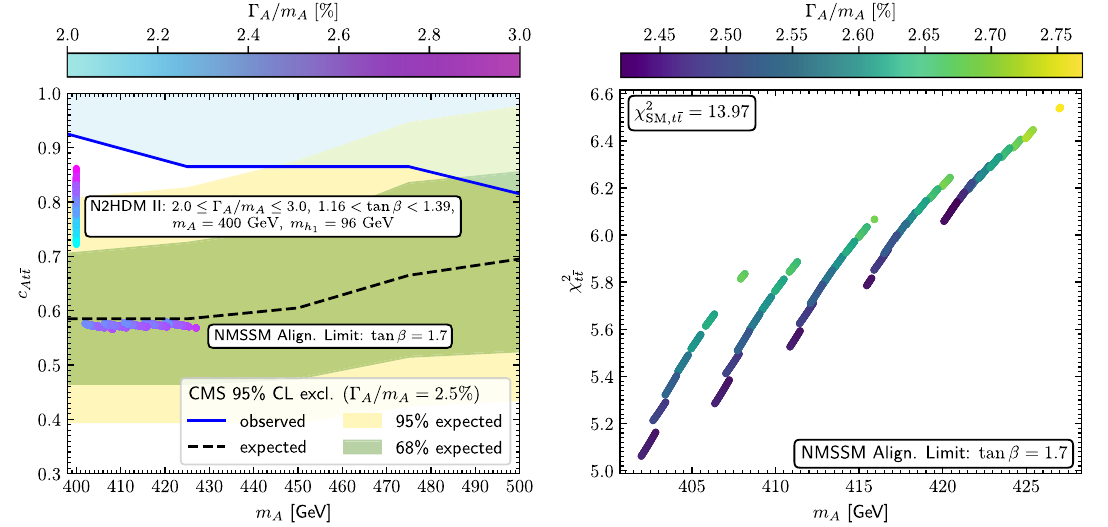
Fig. 13 NMSSM parameter points with χ 2 ≤ χ 2 1 σ (green) and 2 σ (yellow) regions around the expected exclusion limit in the m A – c At ¯ t SM assuming (cid:8) A / m A = 2 . 5%, as published in Ref. [6], and the N2HDM plane (left) and the m A – χ 2 plane (right). The colors of the points indi- t ¯ t parameter points from the scan discussed in Sect. 3.4 with χ 2 ≤ χ 2 catethevaluesof (cid:8) A / m A in%.Left:Alsoshownaretheobserved(blue) and 2 . 0% ≤ (cid:8) A / m A ≤ 3 . and expected (black dashed) upper limits at the 95% CL as well as the